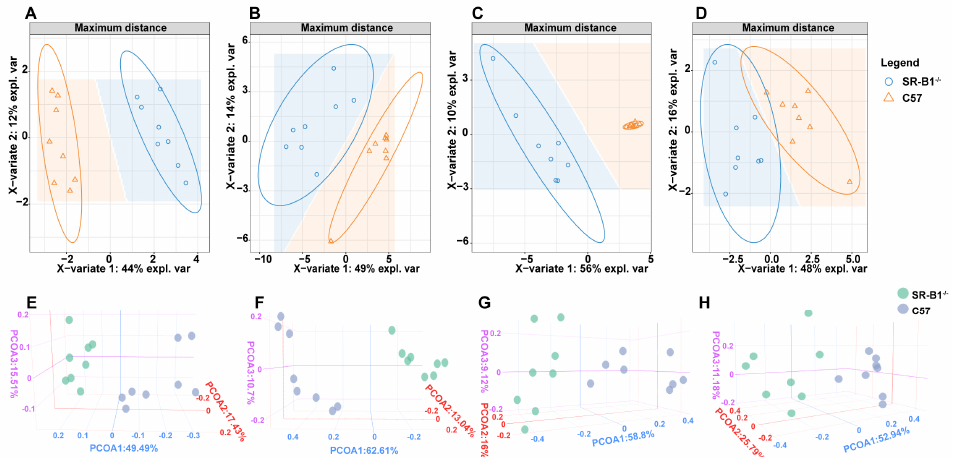
Figure 2. Partial least squares discriminant analysis (PLS − DA) and principal coordinate analysis (PCoA) of the small intestine in the C57 and SR − B1 − / − mice in the negative − ion ( A , E ) or positive − ion ( B , F ) mode ( n = 8); PLS − DA and PCoA of the large intestine in the C57 and SR − B1 − / − mice in the negative − ion ( C , G ) or positive − ion ( D , H ) mode.